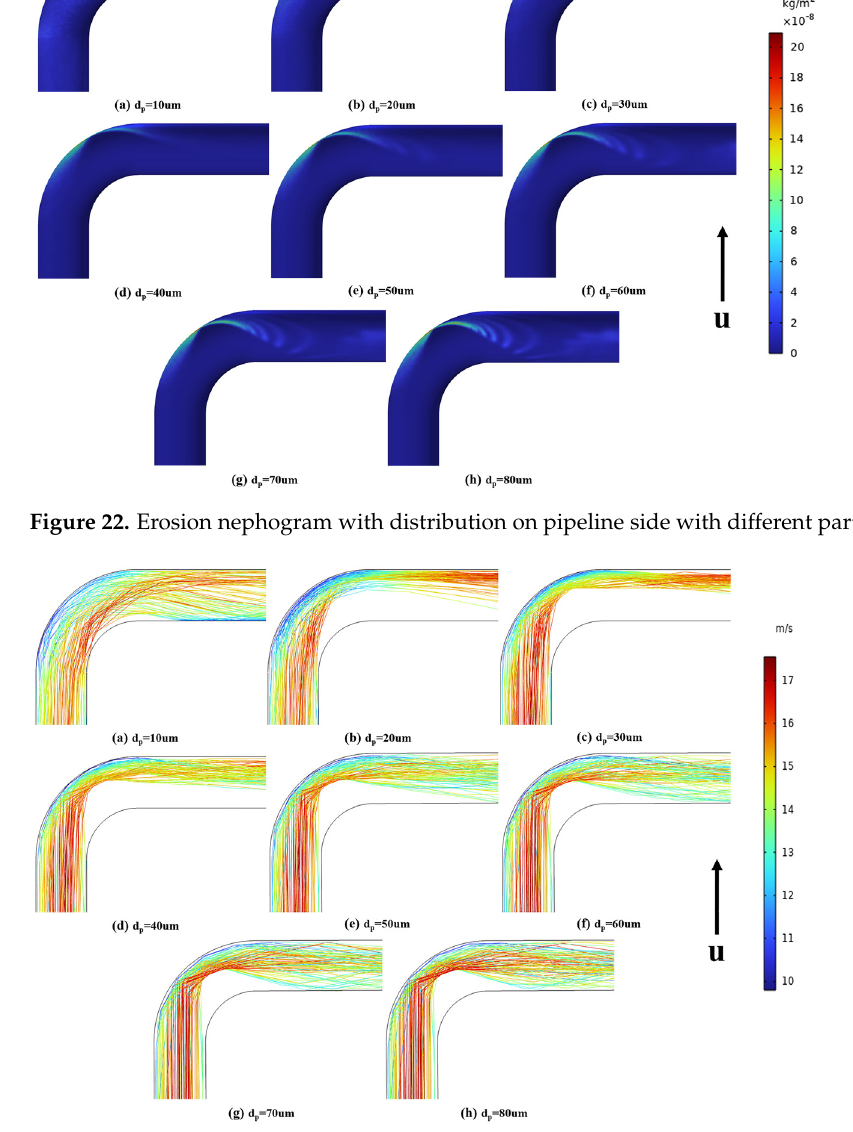
Figure 23. Schematic diagram of particle trace of different particles at elbow.